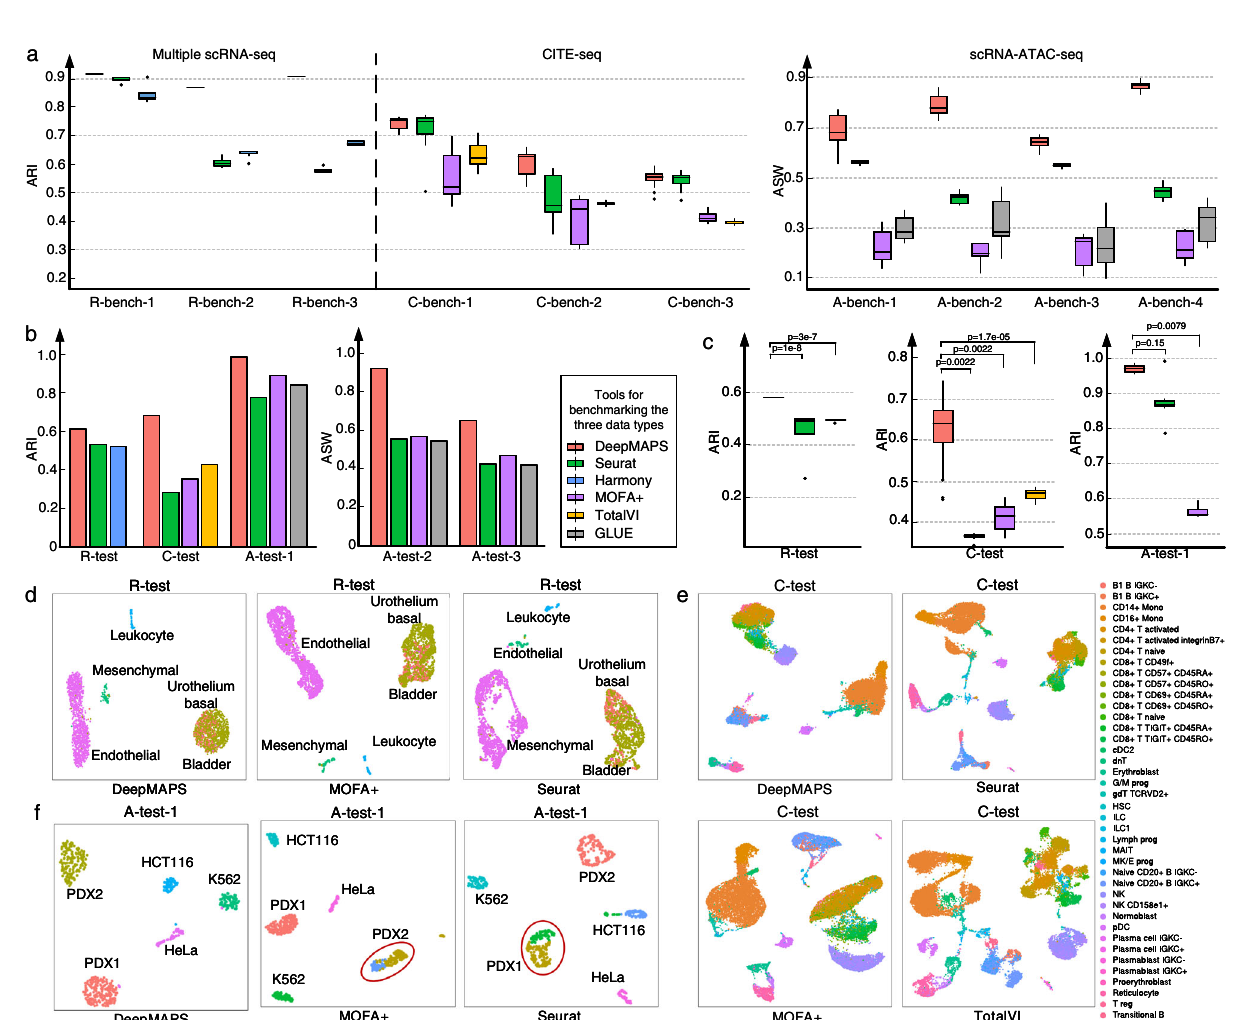
Fig. 1 | The work fl ow of DeepMAPS and HGT illustration. a The overall frame- work of DeepMAPS. Five main steps were included in carrying out cell clustering and biological gene network inference from the input scMulti-omics data. b The graphautoencoderwasinsertedwithaHGTmodel.Theintegratedcell-genematrix was used to build a heterogeneous graph include all cells (green) and genes (pur- ple)asnodes.TheHGTmodelistrainedonmultiplesubgraphs(50subgraphsasan example)thatcovernodesinthewholegraphasmanyaspossible.Eachsubgraphis used to train the model with 100 epochs; thus, the whole training process iterates 5,000 times. The trained model is then applied to the whole graph to learn and